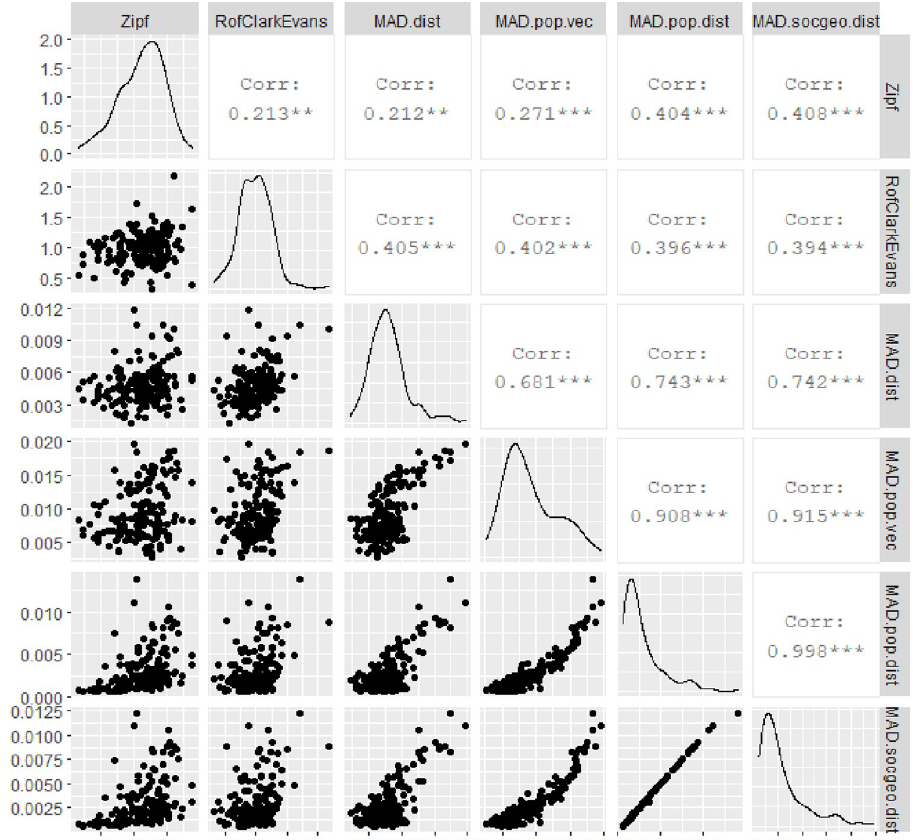
Fig 6. Relations in empirical data. Source: Own study with the use of GGally:: R